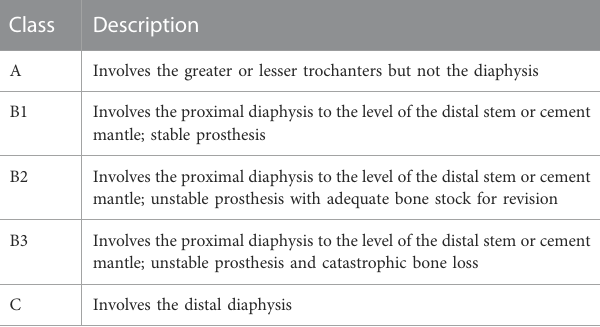
TABLE 1 Vancouver classi fi cation of femoral fractures after total hip